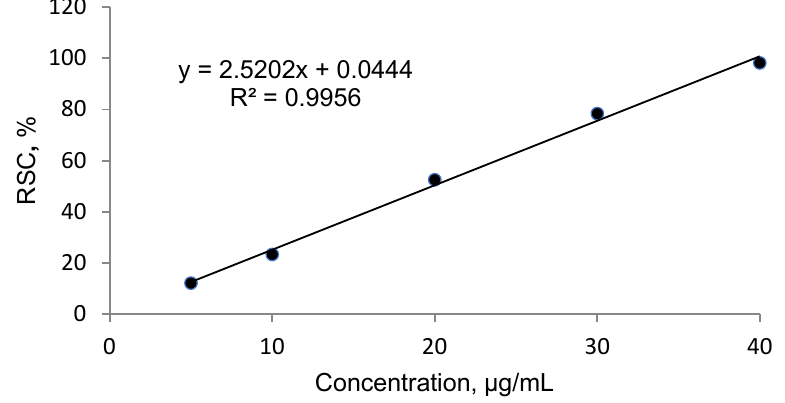
Figure 4. Radical scavenging activity determined in Trolox antioxidant standard solution.